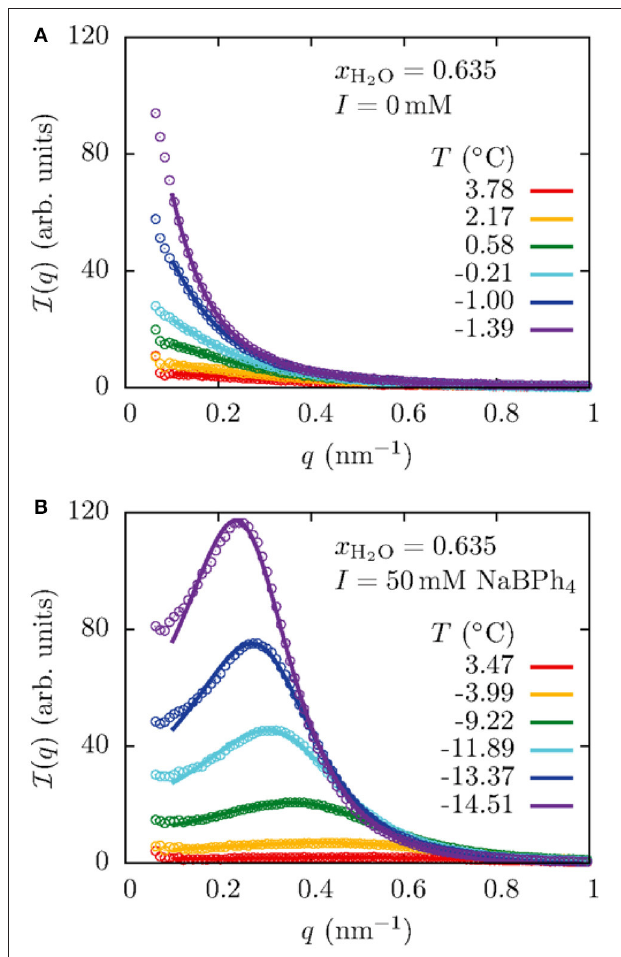
FIGURE 10 | (A) Temperature dependence of the SAXS profiles of the H 2 O/acetonitrile mixture. q denotes the momentum transfer and x H mole fraction of water in the mixture. The solid lines show fitting results according to the Ornstein-Zernike equation. (B) Temperature dependence of the SAXS profiles for the mixture H 2 O/acetonitrile with 50 mmol/L of NaBPh 4 . The solid lines show the fitting result according to the model scattering function for the charge-density-wave structure, taking into account the effect of the long-range monopole-dipole interaction between solvents and ions [31]. The figure is reproduced from Bier et al. [31] with permission from Copyright 2017 by The American Physical